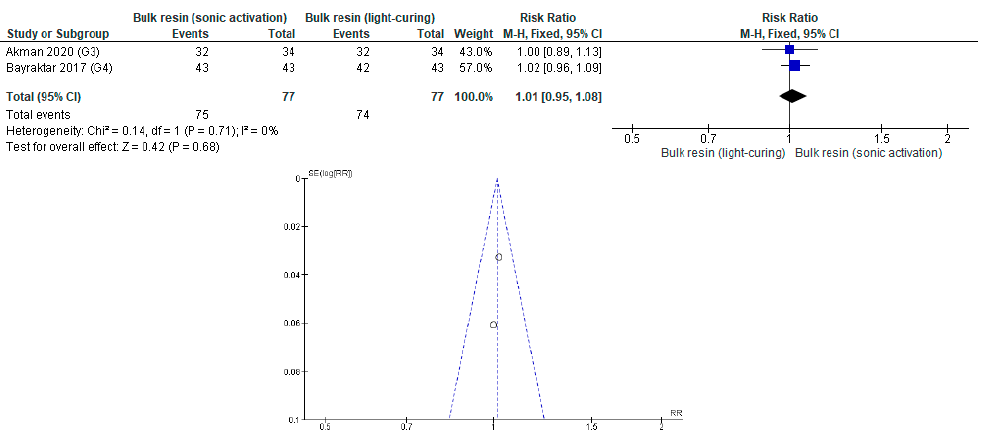
Figure A10. Absence of Discoloration or Marginal Staining: Bulk Resin (with Sonic Activation) versus Bulk Resin (Two-Step Technique).